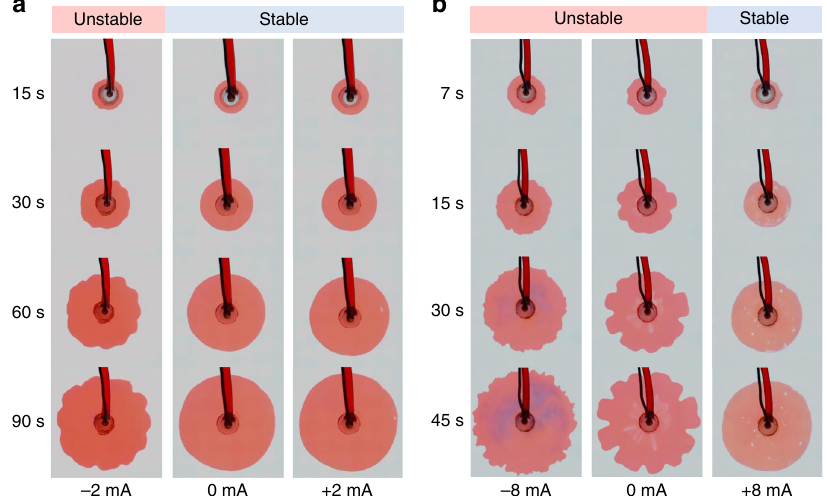
Fig. 3 Representative examples of electrokinetic destabilization and stabilization. a Destabilization of a hydrodynamically stable displacement ( M = μ 1 / μ 2 = 1.98 > 1). μ μ 1 : viscosity of the inner phase (invading). 2 : viscosity of the outer phase (defending). b Stabilization of a hydrodynamically unstable displacement ( M = 0.067 < 1). The videos of the evolution of the interfaces are provided in Supplementary Movie